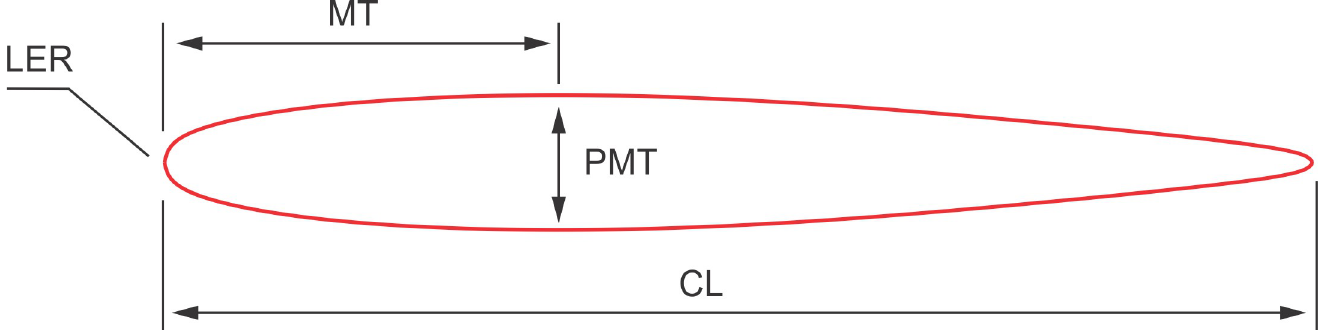
Fig 5. Scheme of the airfoil parameters measured on the cross-sections of fins. CL –chord length, MT –maximal thickness, PMT –position of maximal thickness, LER –leading edge